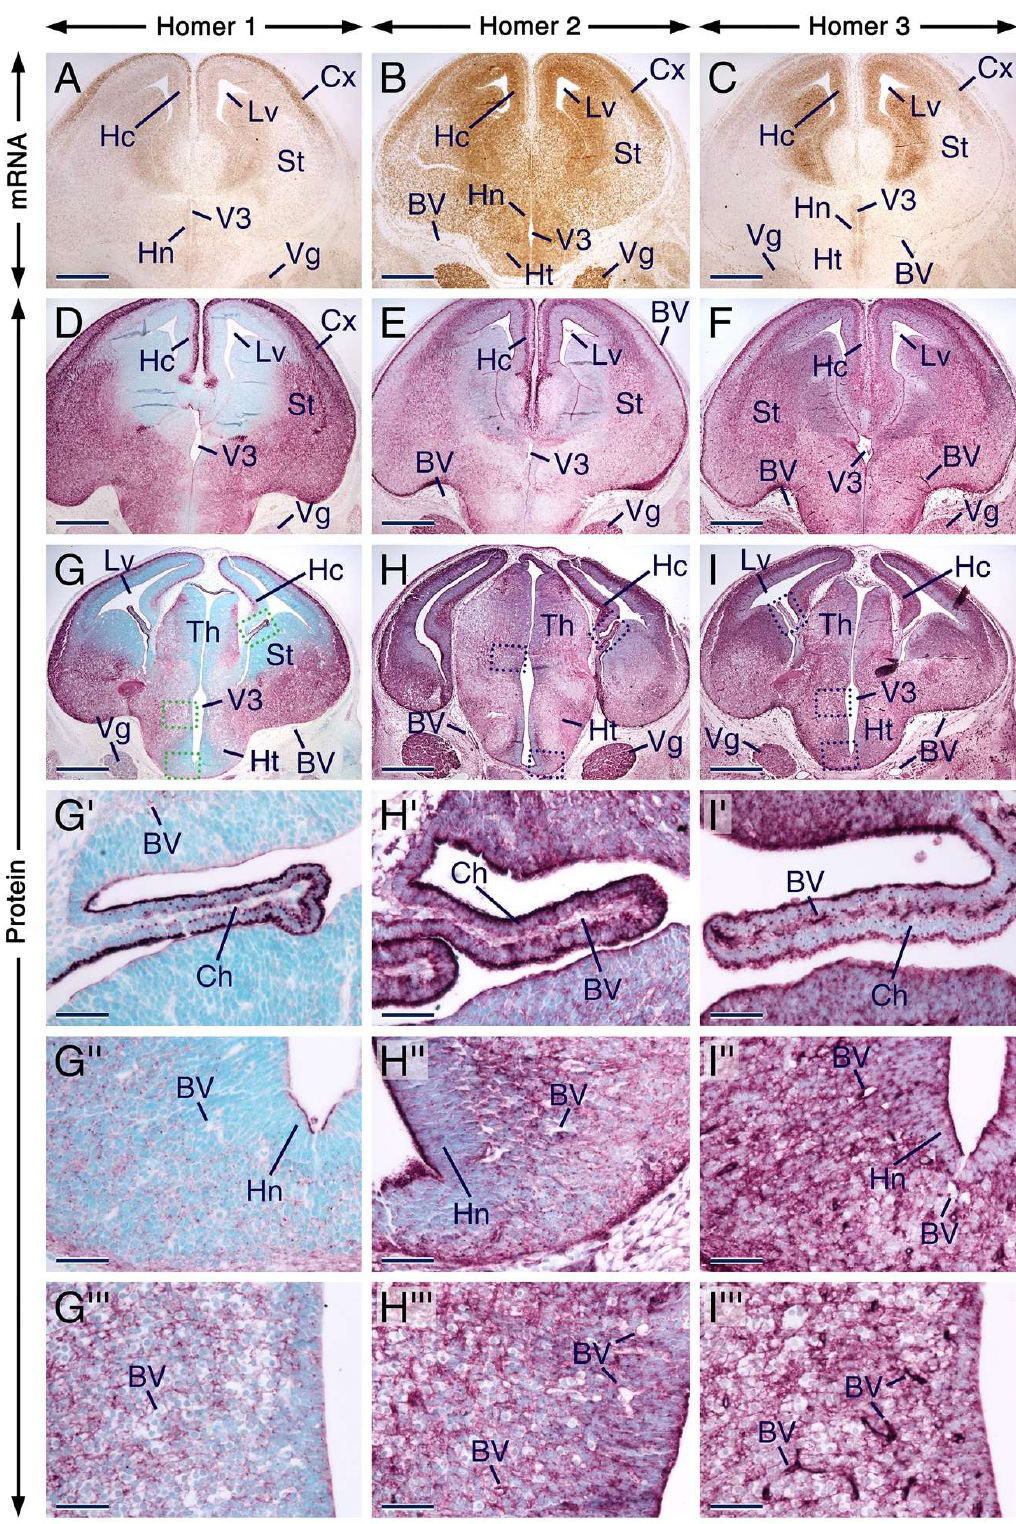
Figure 4. Expression patterns of Homer1, Homer2 and Homer3 in the developing forebrain and trigeminal ganglion. ( A – I ) Representative sections across the forebrain and trigeminal ganglion at embryonic day 14.5 (E14.5) after in situ hybridization revealing Homer transcripts ( A – C ) and immunostaining ( D – I ) for Homer proteins. Homer transcripts (brown) and Homer proteins (purple) are expressed in the trigeminal ganglion and in different regions of the forebrain, including the